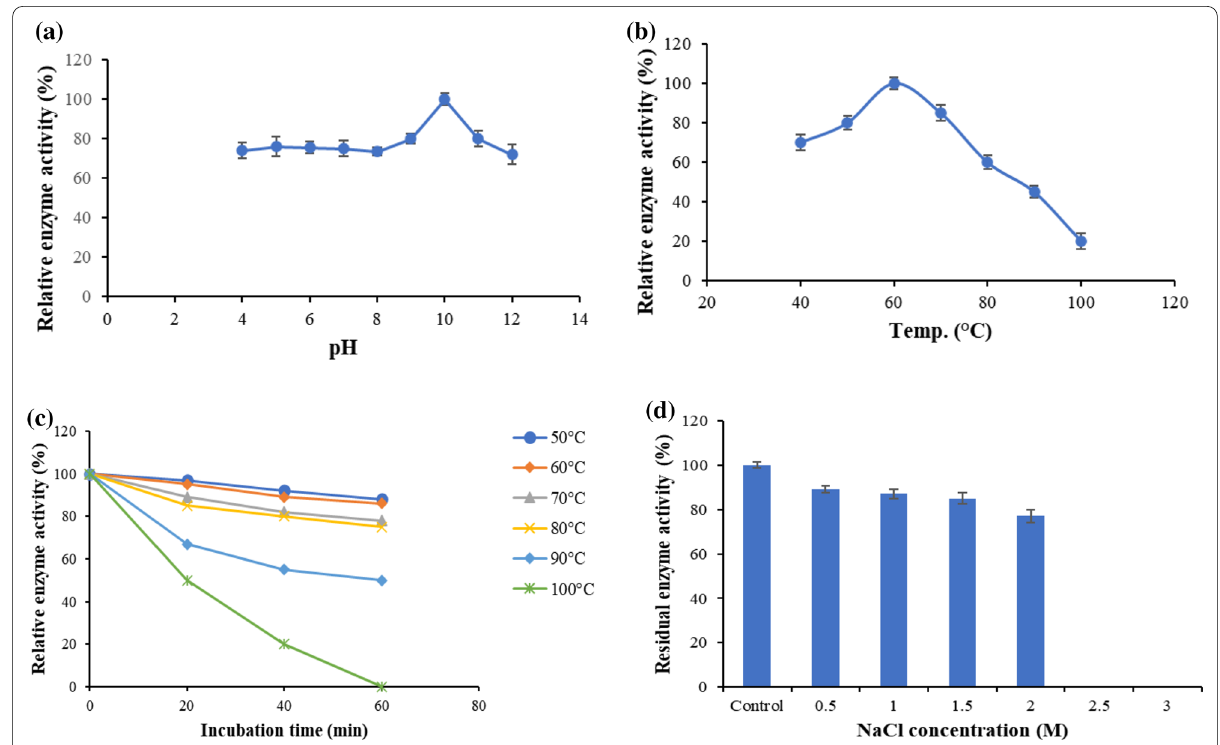
Fig. 5 Effect of a pH, and b temperature on rMtCel6A activity, c Thermostability of rMtCel6A, d Effect of NaCl on rMtCel6A activity